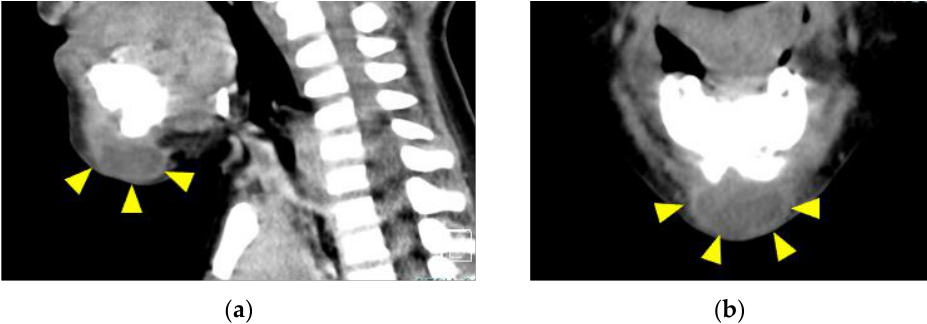
Figure 4. CT images: ( a ) sagittal section and ( b ) coronal section. An abscess cavity was evident in the submental area (yellow arrowheads).